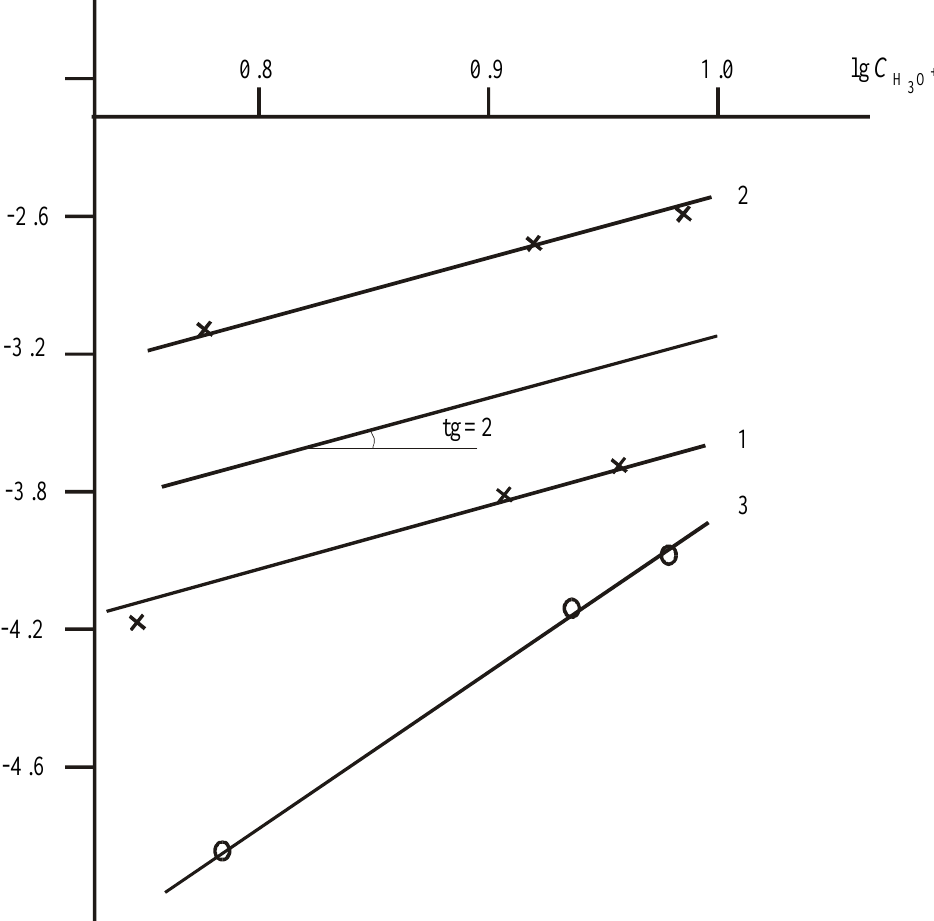
& OJ dependence for CuPc(3-NO - + 2+ REV (cid:22) COOH) (3). T,K: 1 - 379, 2,3 - 8